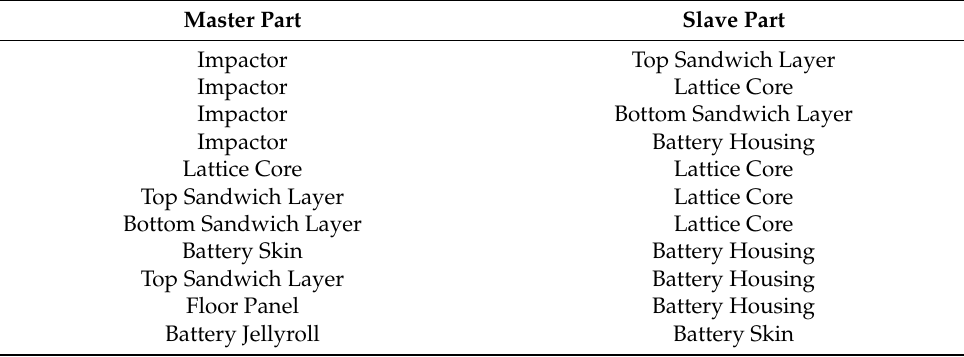
Table 13. Master and Slave Parts of Defined Contact Parameters.